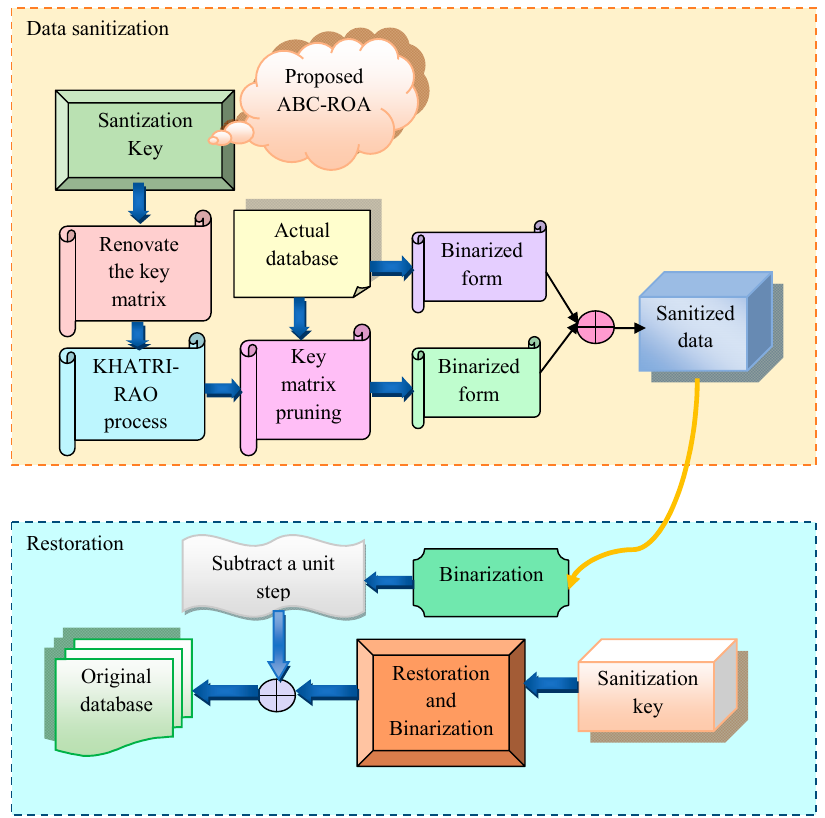
Figure 3. Data sanitization and data restoration process in the blockchain-based privacy preserva- tion system.